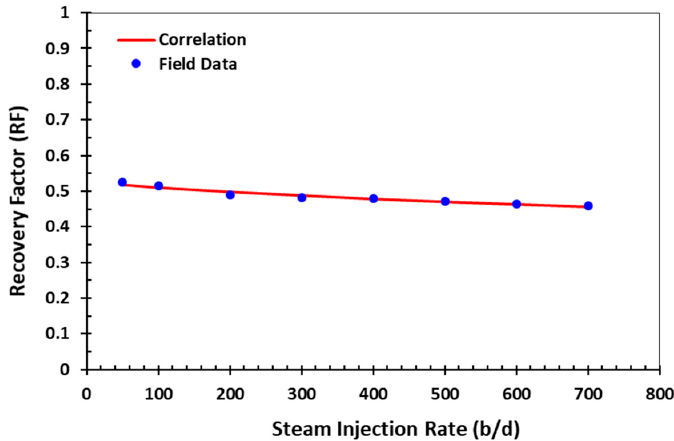
Figure 10. Residuals vs. gross to net thickness ratio for the database analyzed.